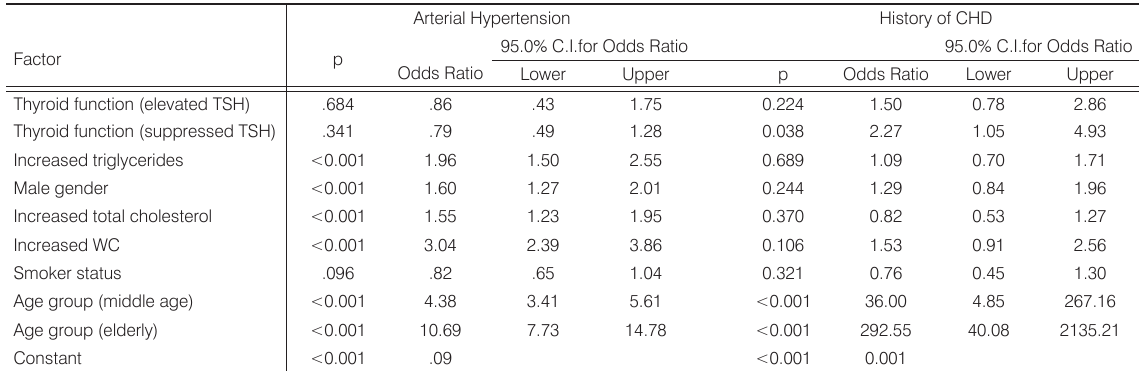
Table 4. Binary logistic regression analysis. Arterial hypertension and CHD history are the dependent variable and thyroid function, Triglycerides >1.7 mmol/l, cholesterol >5.2 mmol/l, smoking, male gender and increased waist circumference are the independent. The reference category for thyroid function is euthyroidism, The reference category for age group is 20-44 y. R-square for the arterial hypertension model is 0.379 and for the IHD it is